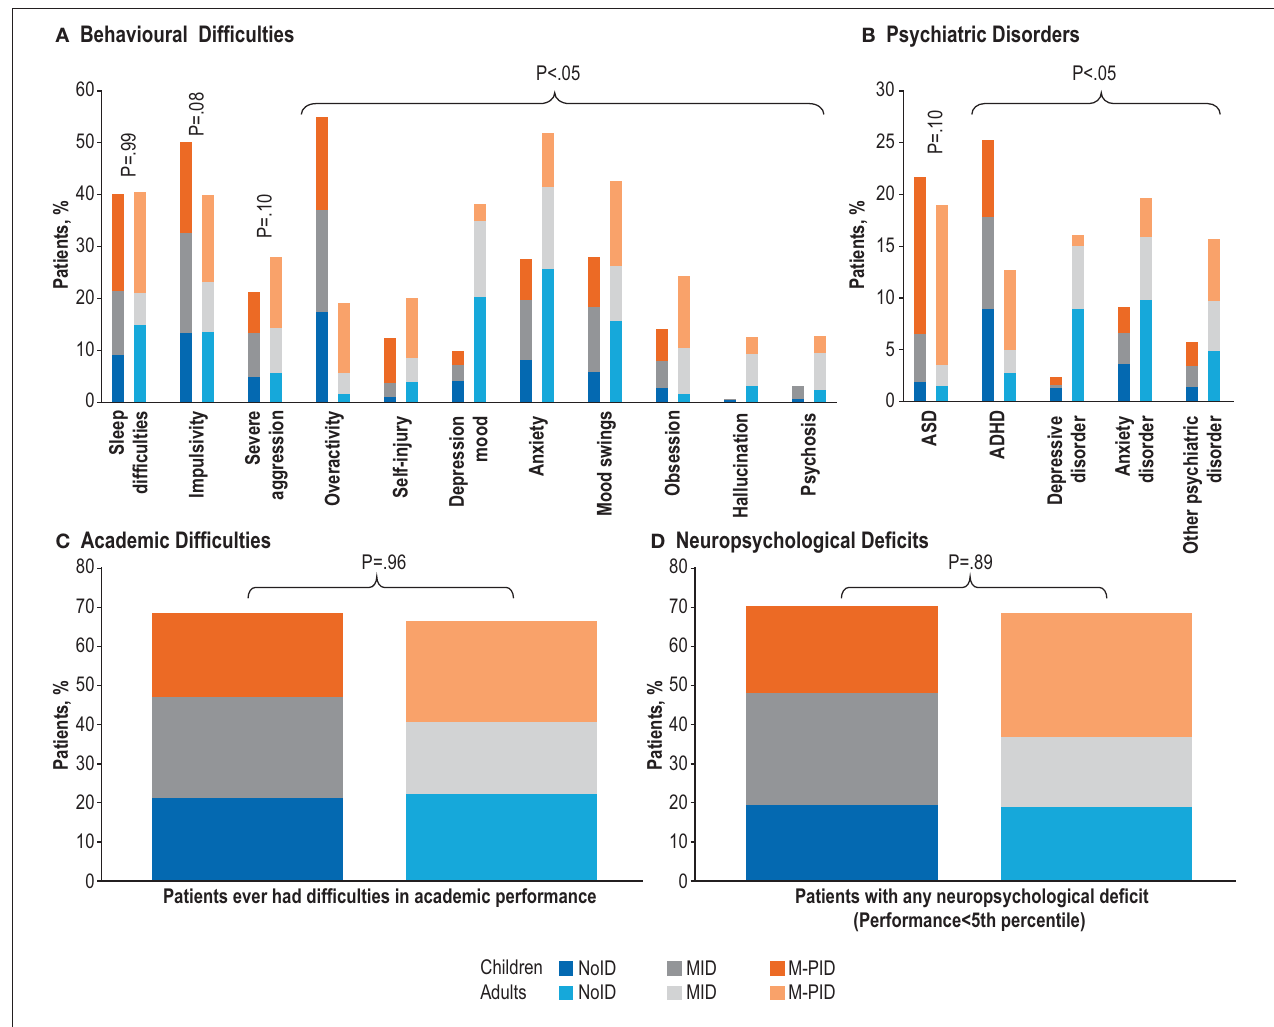
FIGURE 1 | Frequency of TAND features stratified by levels of intellectual ability (noID [IQ > 70], MID [IQ 50–70] and M-PID [IQ < 50]) in children vs. adults. (A) Behavioral difficulties. (B) Psychiatric disorders. (C) Academic difficulties. (D) Neuropsychological deficits. Percentages calculated excluding missing/unknown data.